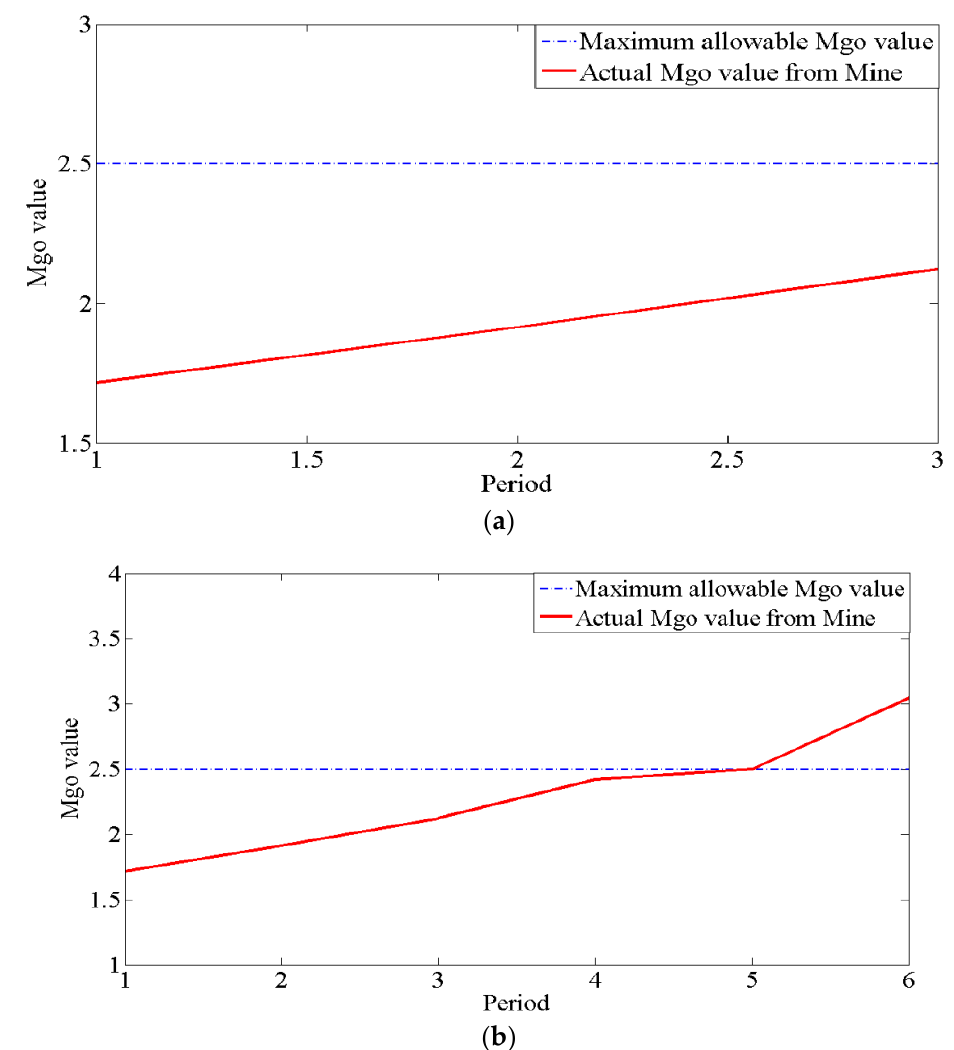
Figure 7. ( a ) Model 1 MgO value up to three periods with MgO upper bound; ( b ) MgO value up to 6 periods from Model 1 with upper bound of MgO.